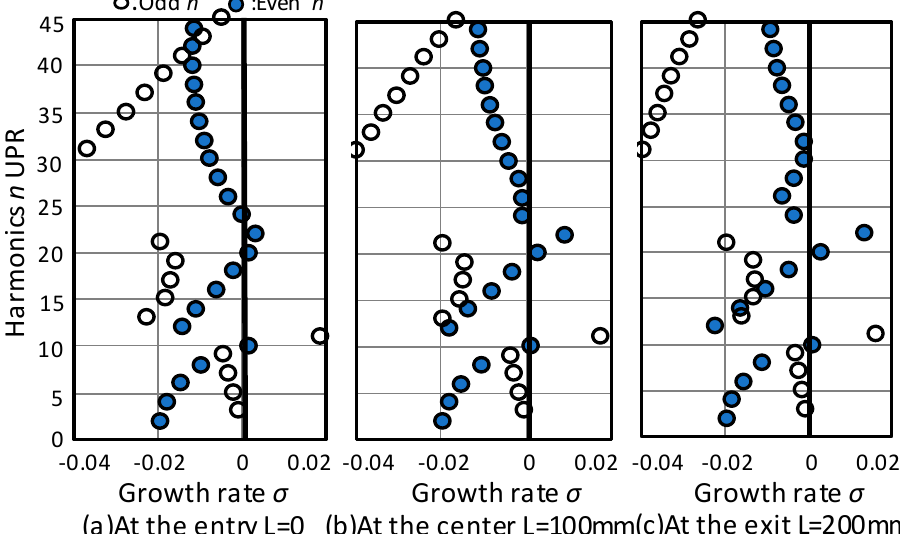
Figure 4. Characteristic roots at the different grinding points. ( a ) At the entry L = 0; ( b ) At the center L = 100 mm; ( c ) At the exit L = 200 mm. Conditions: dw = 25 mm; Iw = 30 mm, ds = 455; Lg = 200 mm, dr = 300 mm, γ 0 = 6.75°, Nr = 50 rpm, ξ = 1.5 ˚ , kw’ = 2 kN/mm, kcr’ = 3 kN/mm, kcs’ = 1 kN/mm, km = 60 kN/mm, fn 1 = 100 Hz, fn 2 = 200 Hz, ζ 1 =0.08, ζ 2 = 0.05, Zcs = 1, Zcr = 1.0, ε 1 (L) = 0